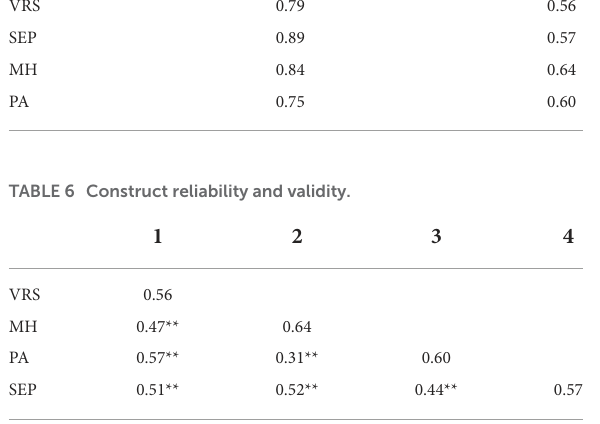
TABLE 5 Reliability.